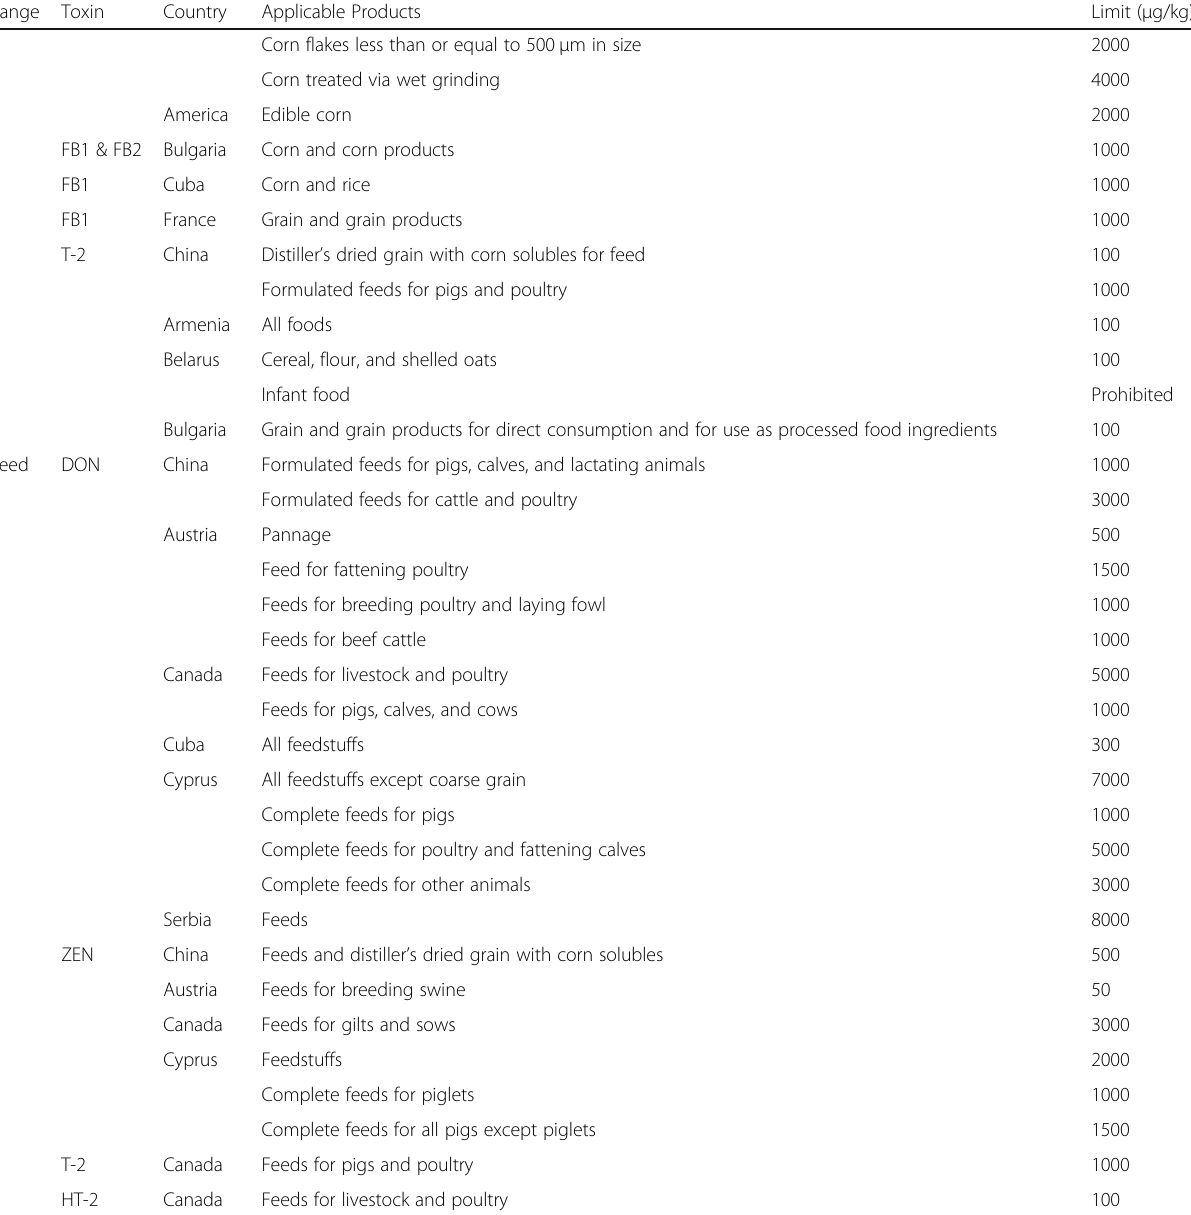
Table 1 Allowable limits of Fusarium mycotoxins in food and feeds in certain countries and regions (Continued) Range Toxin